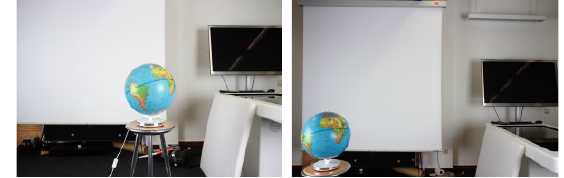
Figure 3: Images of a globe in two different image positions